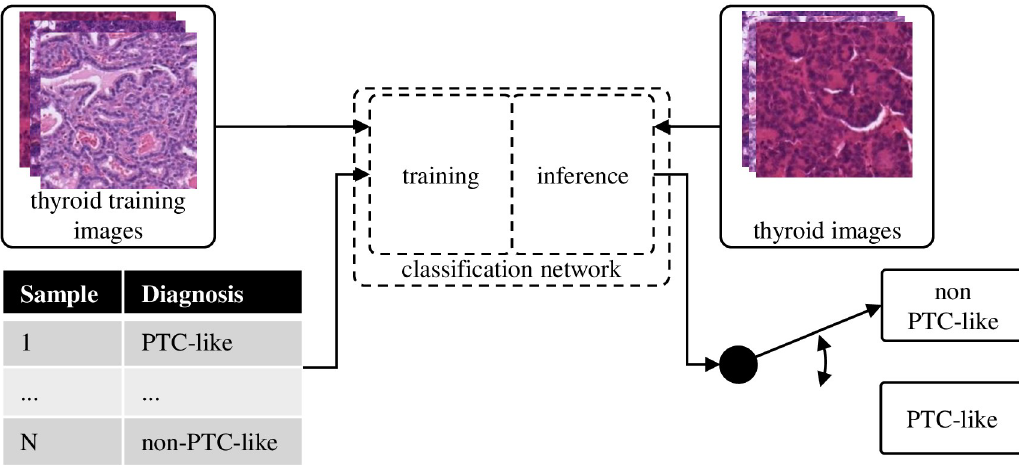
Fig 4. The deep learning-based classification performs the classification directly on the thyroid images.